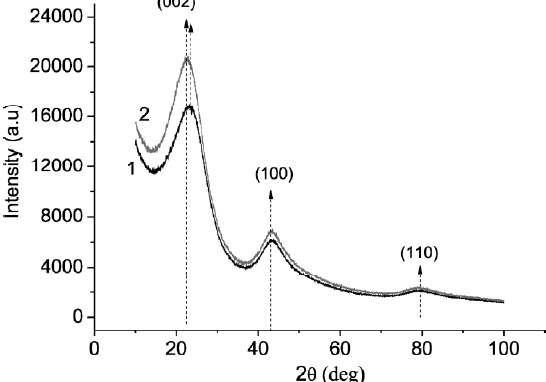
Fig. 2. X-ray diffraction patterns of non-activated biocarbon bioC_0 (1) and activated biocarbon bioC_31 (2).